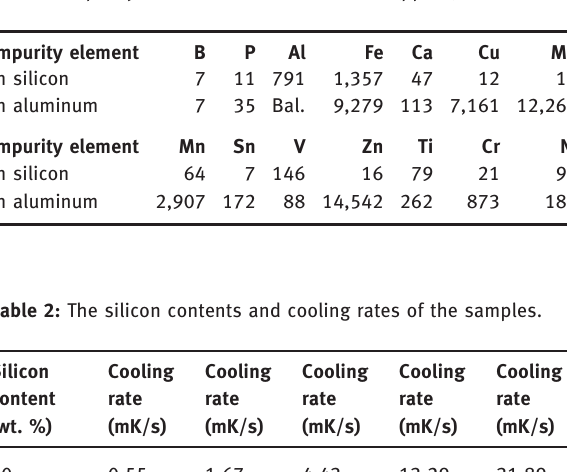
Figure 1: Boron contents in the primary silicon phases and eutectic silicon phases in the Al-30% Si alloys.